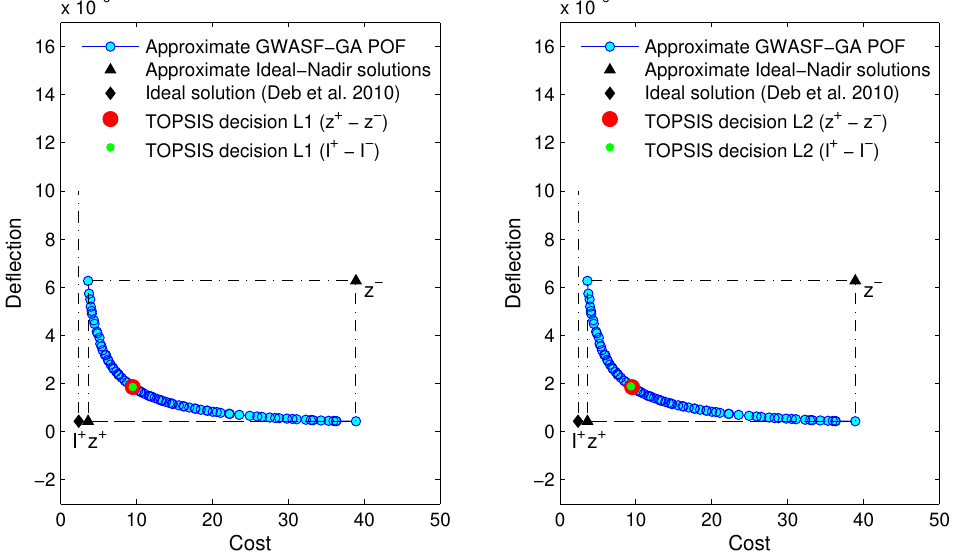
Figure 15. TOPSIS decision with L 1 ( left ) and L 2 ( right ) metrics on the approximate POF with the hypervolume indicator closest to the average value of hypervolume after 100 runs for GWASF-GA ( N =